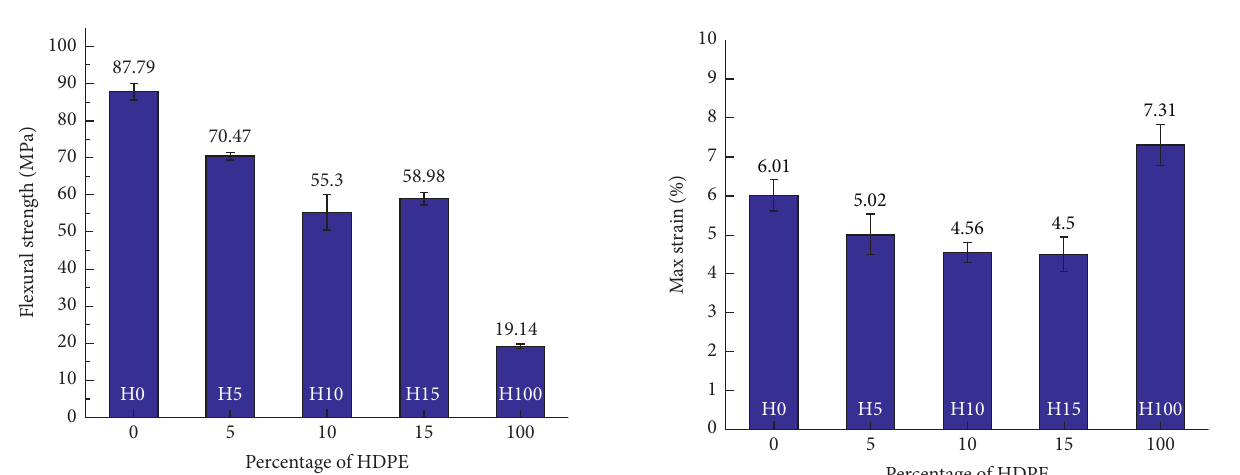
Figure 13: Effects on max-strain in different compositions of